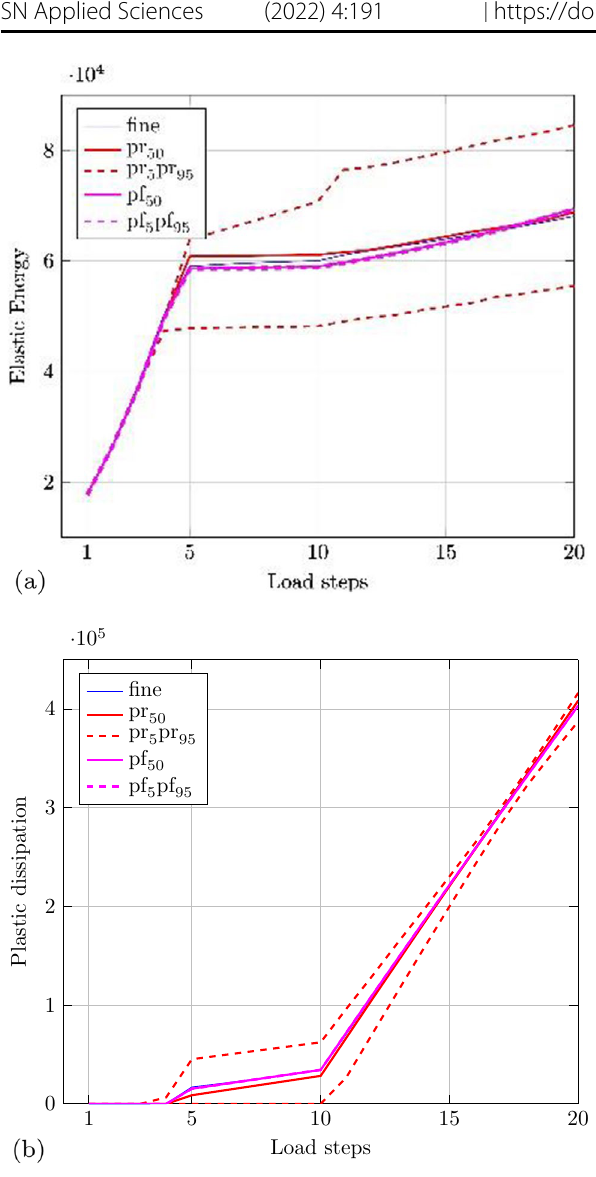
Fig. 11 Macro energy and dissipation. Left: elastic energy. Right: plastic